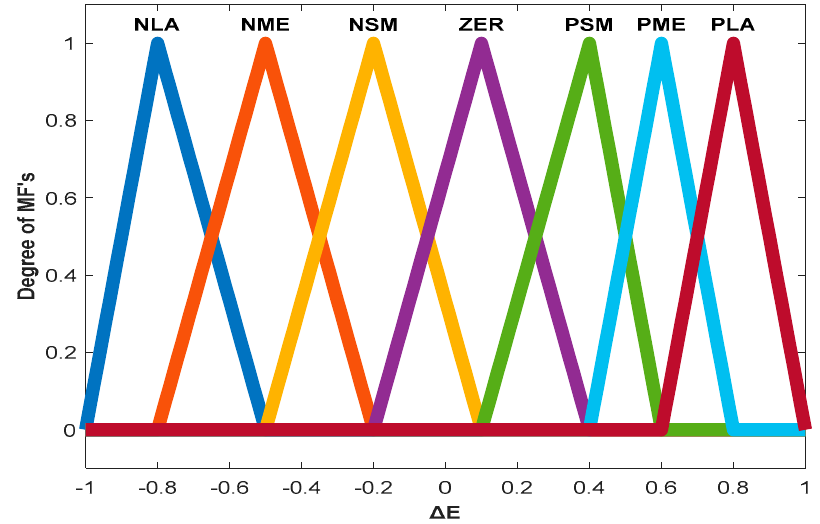
Figure 7. Input variable MFs of error ( Δ E).